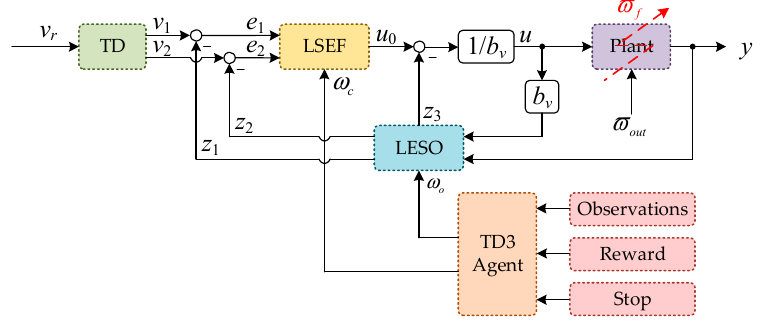
Figure 5. Control schematic of TD3-LADRC.